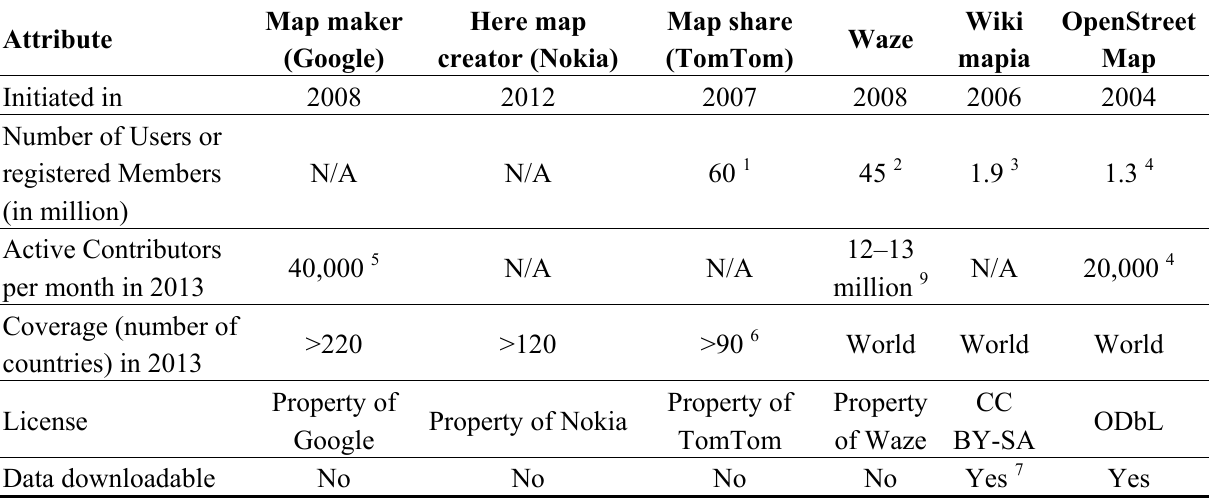
Table 1. Comparison of volunteered geographic information (VGI) projects. ODbL, Open Database License; API, application programming interface; N/A, not available; CC BY-SA, Creative Commons Attribution-Share